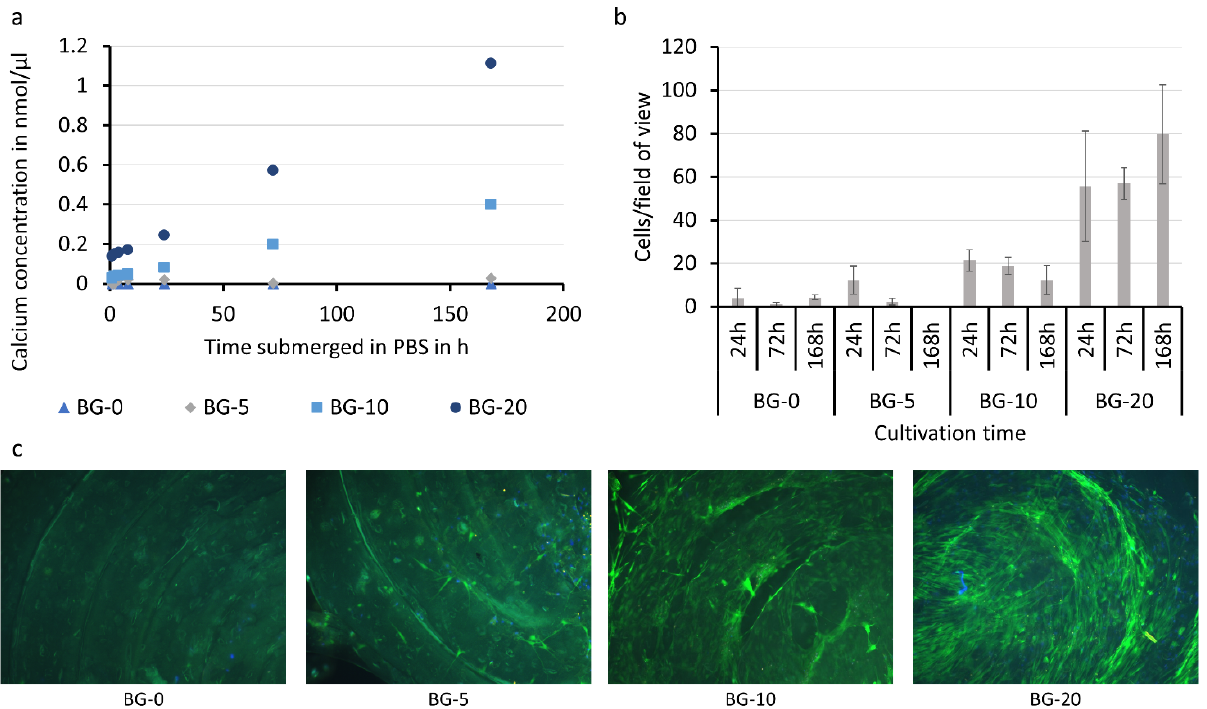
Figure 5. Bio-chemical properties of the PLA-bioglass composite filaments. Calcium release of PLA- bioglass composite samples submerged in PBS ( a ). Adhesion and proliferation of MSC on composite samples (Means ± SD, n = 3) ( b ) and exemplary fluorescence images of MSC seeded on the samples after 24 h (staining green: calcein, blue (cell nuclei): DAPI) ( c ).